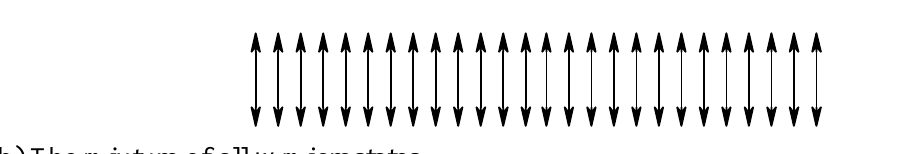
Figure. 3. Dynamic motion of spin-up and spin-down binary system. (a) A microstate. (b) The mixing of all microstates defines a symmetric macroscopic state.